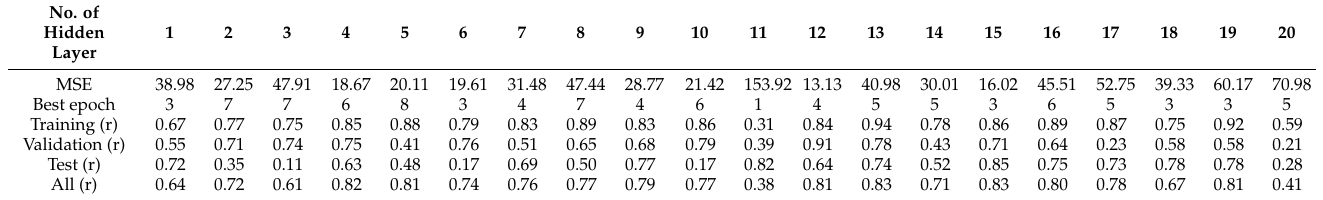
Table 4. Results according to the number of hidden layer.